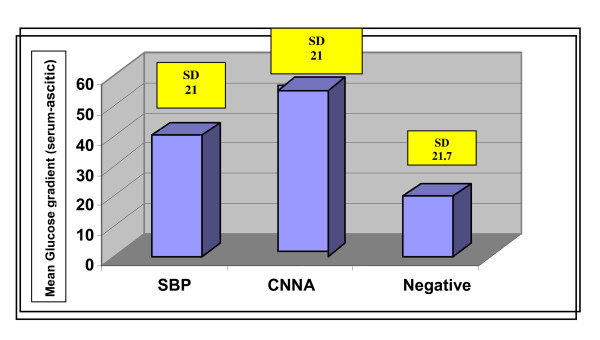
Histogram for the mean values (±SD) of glucose gradient mg/dl (Serum-asitic fluid) in different studied groups.